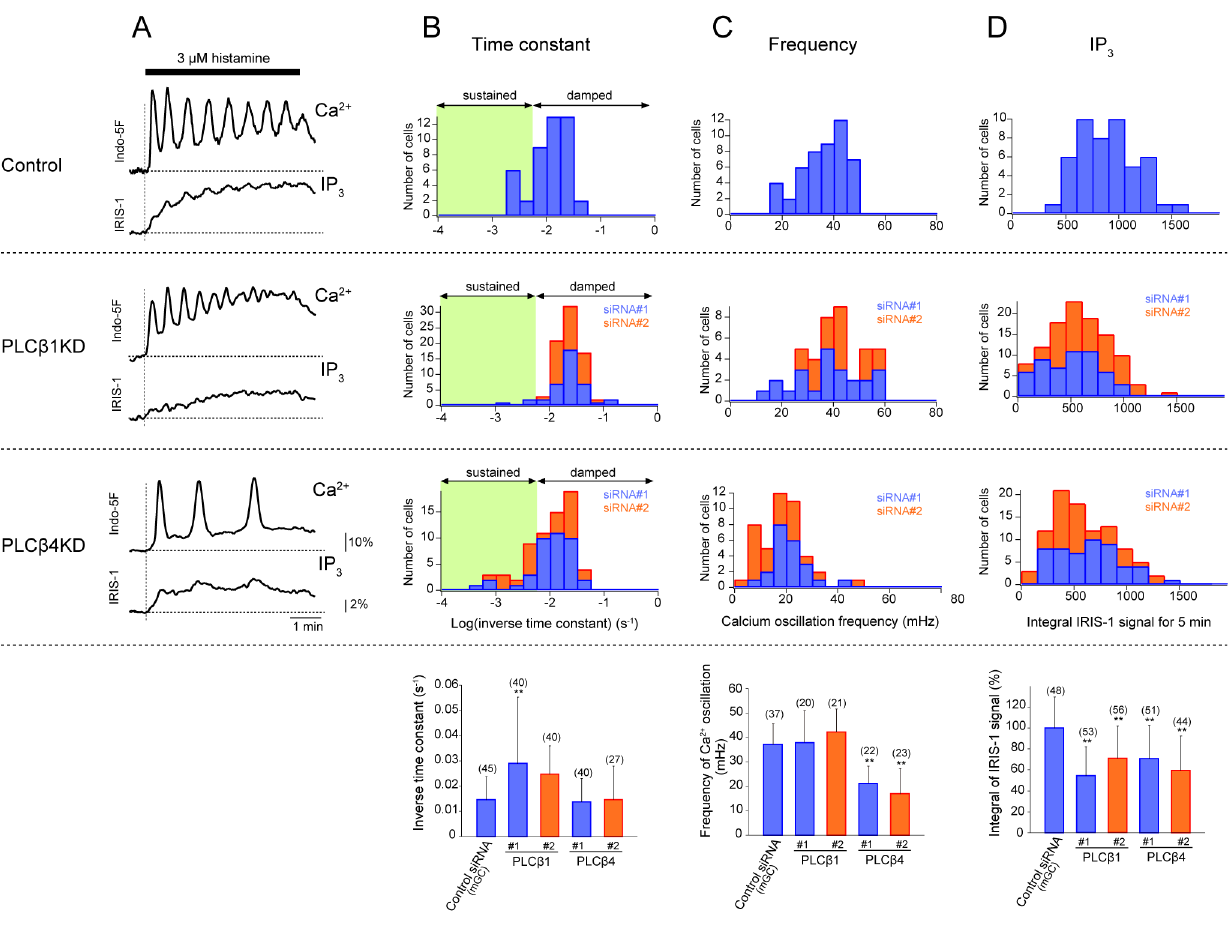
Figure 5. Effects of PLC- b 1 or PLC- b 4 knockdown on Ca 2 + and IP 3 dynamics evoked by histamine stimulation. (A) Representative traces of Indo-5F signal changes (F/F 0 ; top) and IRIS-1 signal changes ( D R/R 0 ; bottom) in siRNA-treated cells stimulated with 3 m M histamine. The siRNAs used are shown on the left. The horizontal broken lines indicate the baseline levels of the IRIS-1 and Indo-5F signals. The vertical broken lines indicate the onsets of stimulation. Stacked histograms of the inverse time constants for exponential decay of the Ca 2 + oscillation amplitude (B), Ca 2 + oscillation frequencies (C), and integrated IP 3 signals (D) of cells treated with control siRNA (top row), PLC b 1KD siRNAs (second row), and PLC b 4KD siRNAs (third row). The results for the two siRNAs are shown in different colors. The means 6 SD are shown at the bottom. The numbers of cells measured are shown in parentheses. Statistical analyses were performed by one-way ANOVA followed by Scheffe’s multiple comparison test. **P , 0.01, vs. the values in control siRNA mGC-transfected cells.